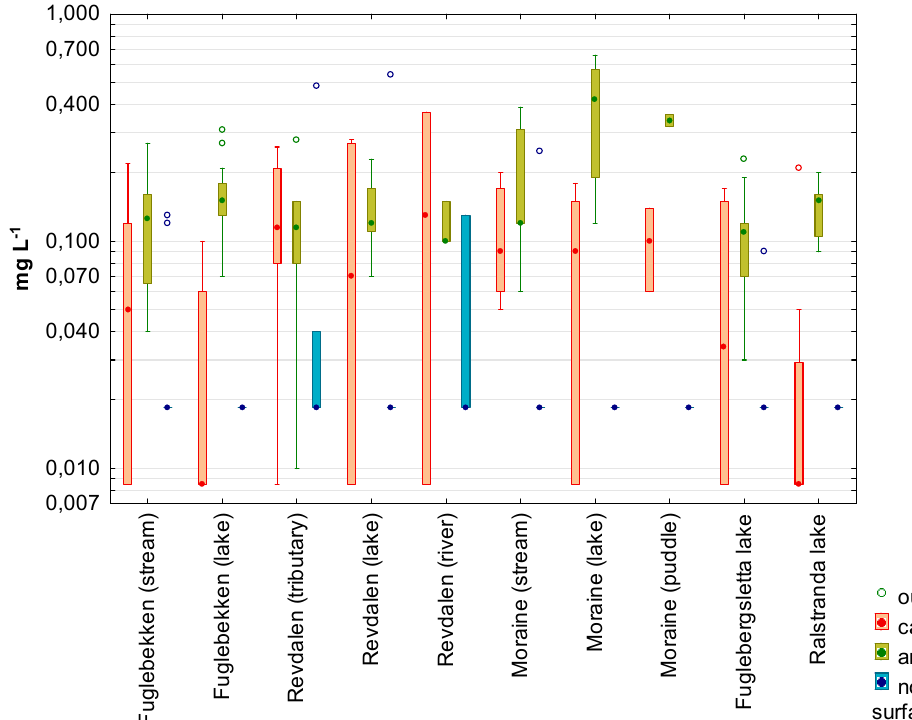
Figure 7. Concentrations of three groups of surfactants in the surface waters from Hornsund area. Box = results between first (Q 1 ) and third quartile (Q 3 ); filled circle = median (Q 2 ); whiskers = range of non-outlier results; outlier (empty circle) = a value further than 1.5 box span (Q 3 − Q 1 ) beyond Q 3 or Q 1 .